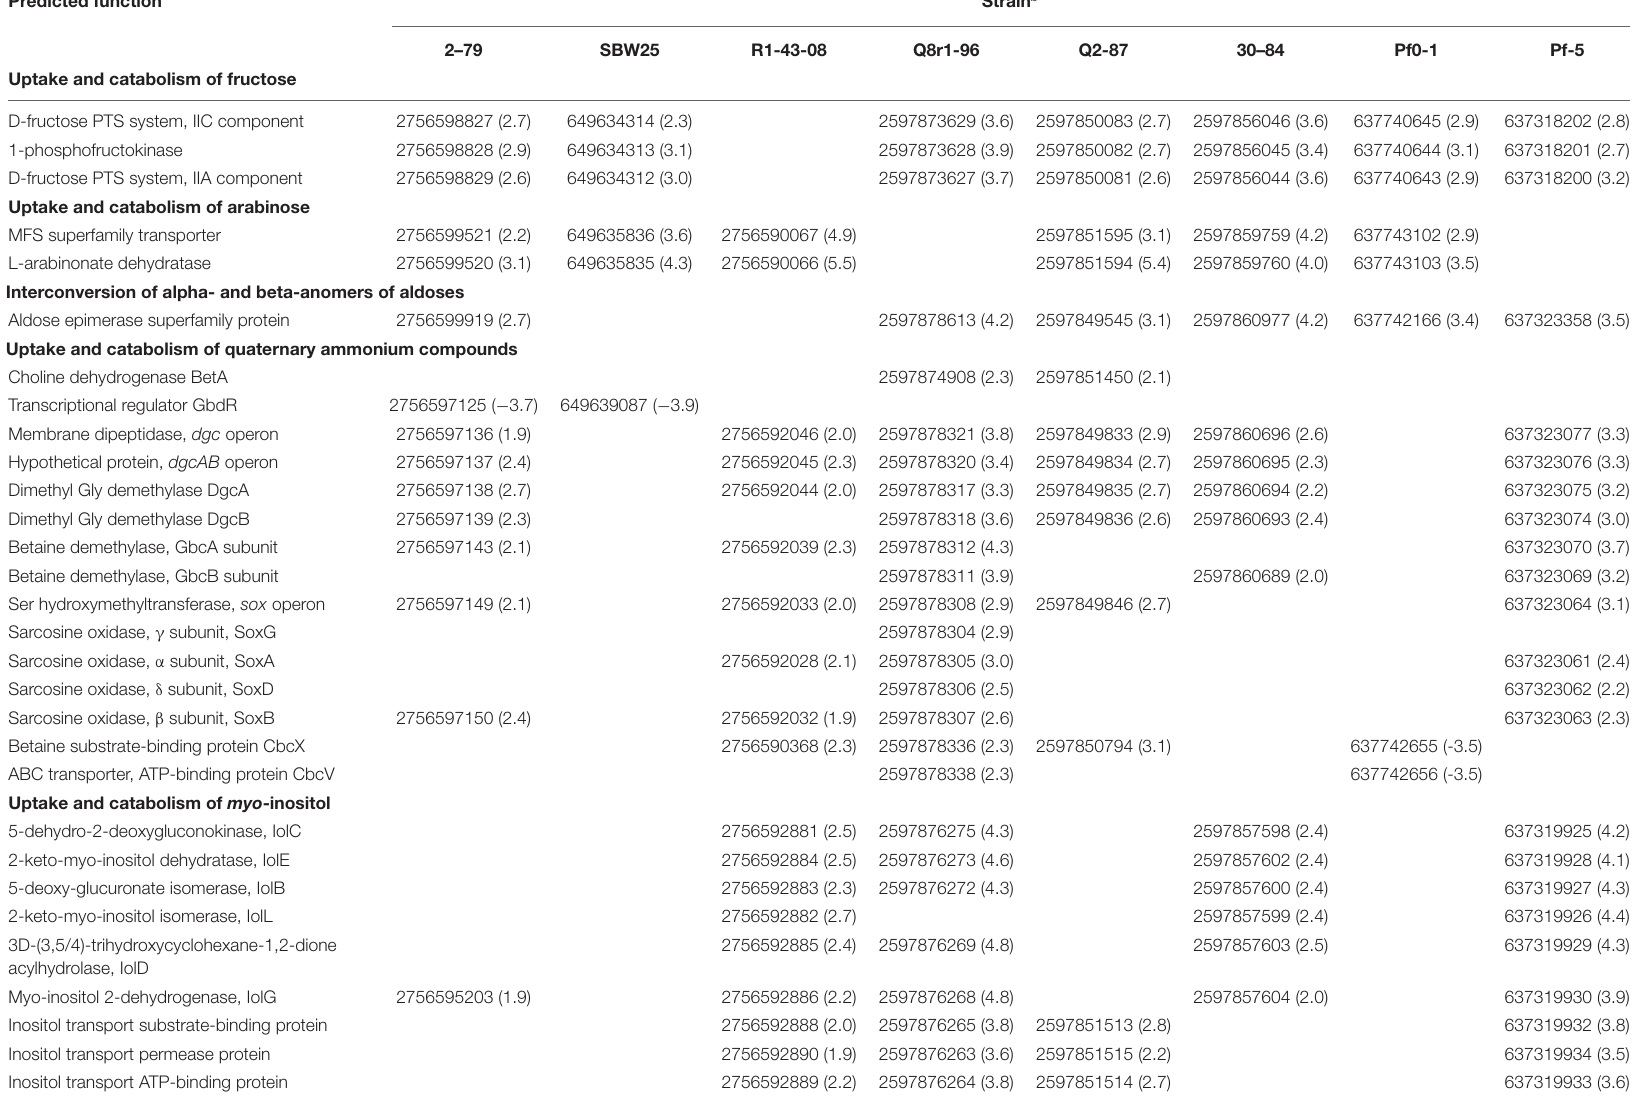
TABLE 2 | The distribution and predicted functions of selected differentially expressed genes a . Predicted